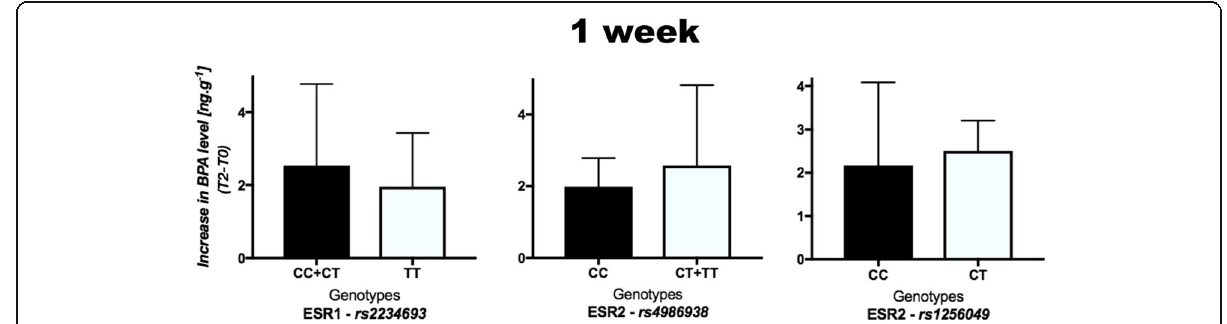
Fig. 2 Means (SD) of the increase of BPA levels in urine 1 week after bracket bonding (T2 – T0) according to